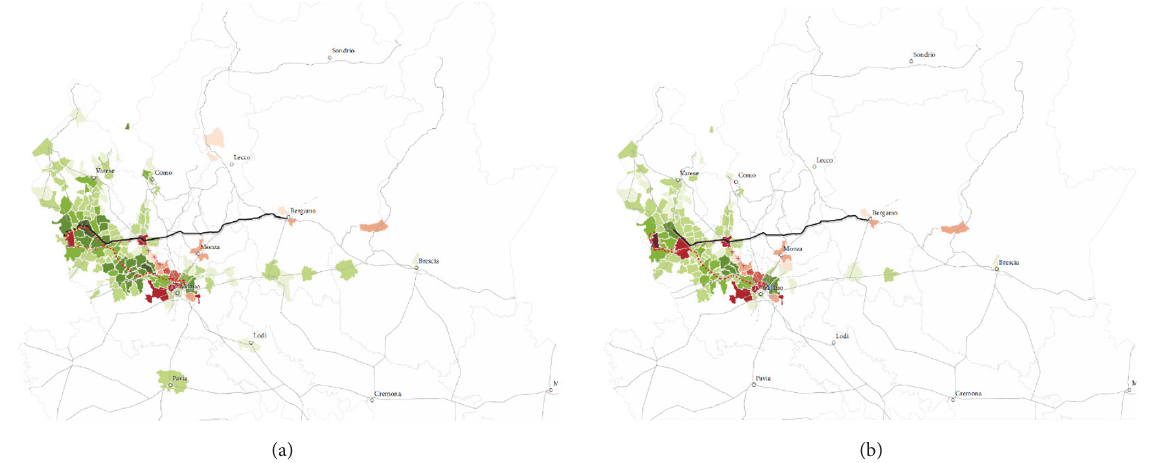
Figure 8: Total variation in user surplus. (a) Scenario R 25 | P 25s1; (b) scenario R 25 | P